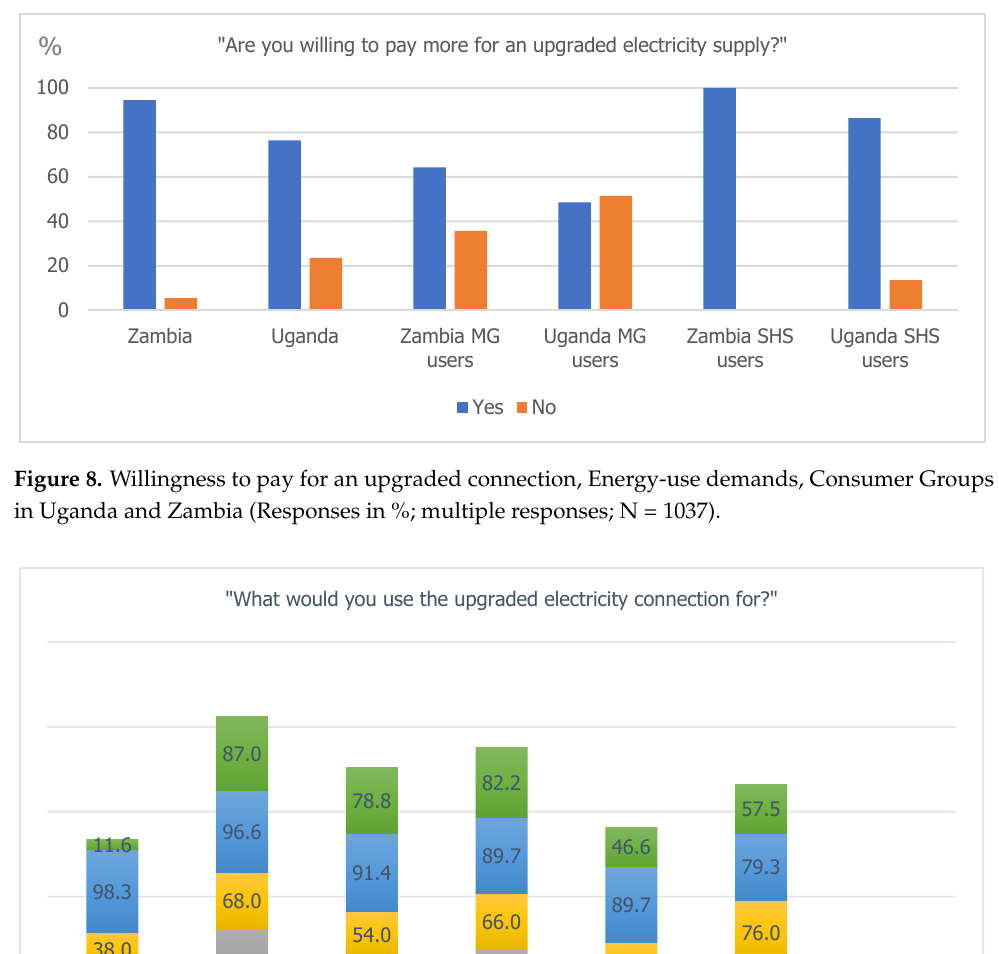
Figure 7. Desire for upgraded electricity supply Consumer Groups in Uganda and Zambia (Re- sponses in %; N = 1037).